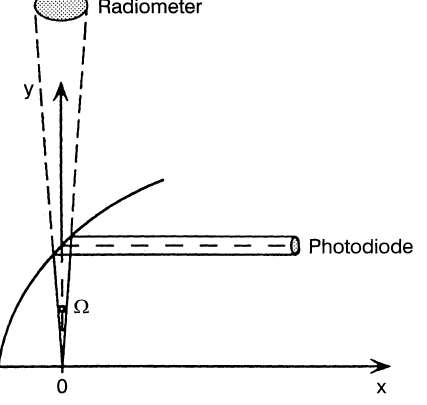
Fig. 9. Schematic diagram of the detector calibration